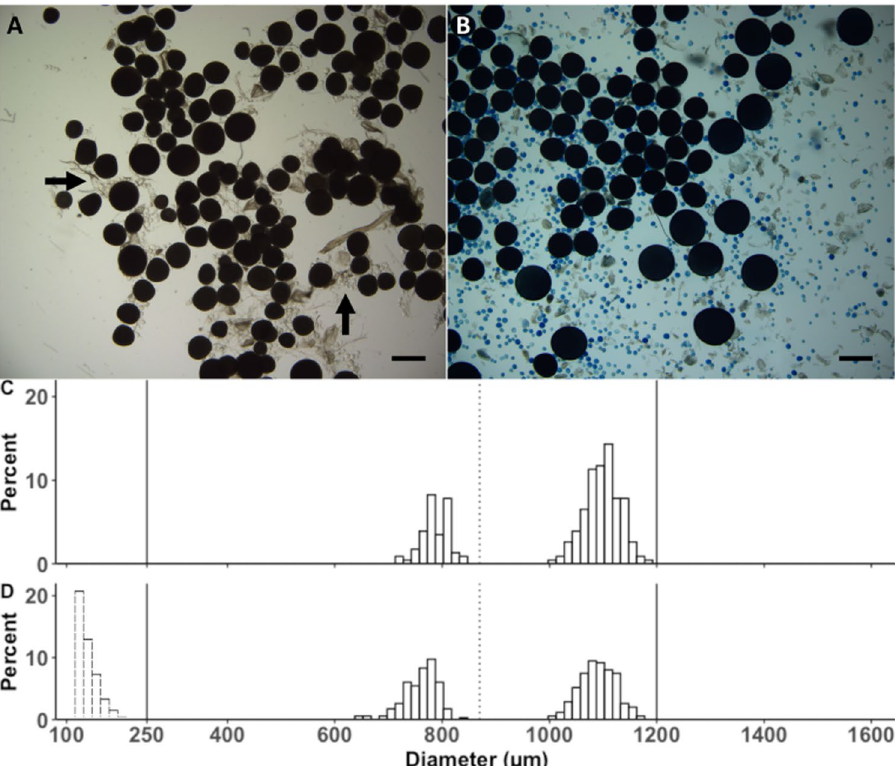
Figure 8. The effect of ultrasonication on oocyte integrity and countability. Representative whole-mount micrographs of ovarian samples before ( A ) and after ( B ) ultrasonication treatment and staining. ( A ) Small and transparent PVOs are densely packed and hardly noticeable (black arrow). ( B ) After ultrasonication and staining, PVOs are well defined and separated. Scale bar = 1000 µ m. Oocyte size frequency distribution of a representative fish before ( C ) and after ( D ) ultrasonication and staining. In D the distribution of PVOs following ultrasonication is indicated by the dashed bars. Other details as for Fig.